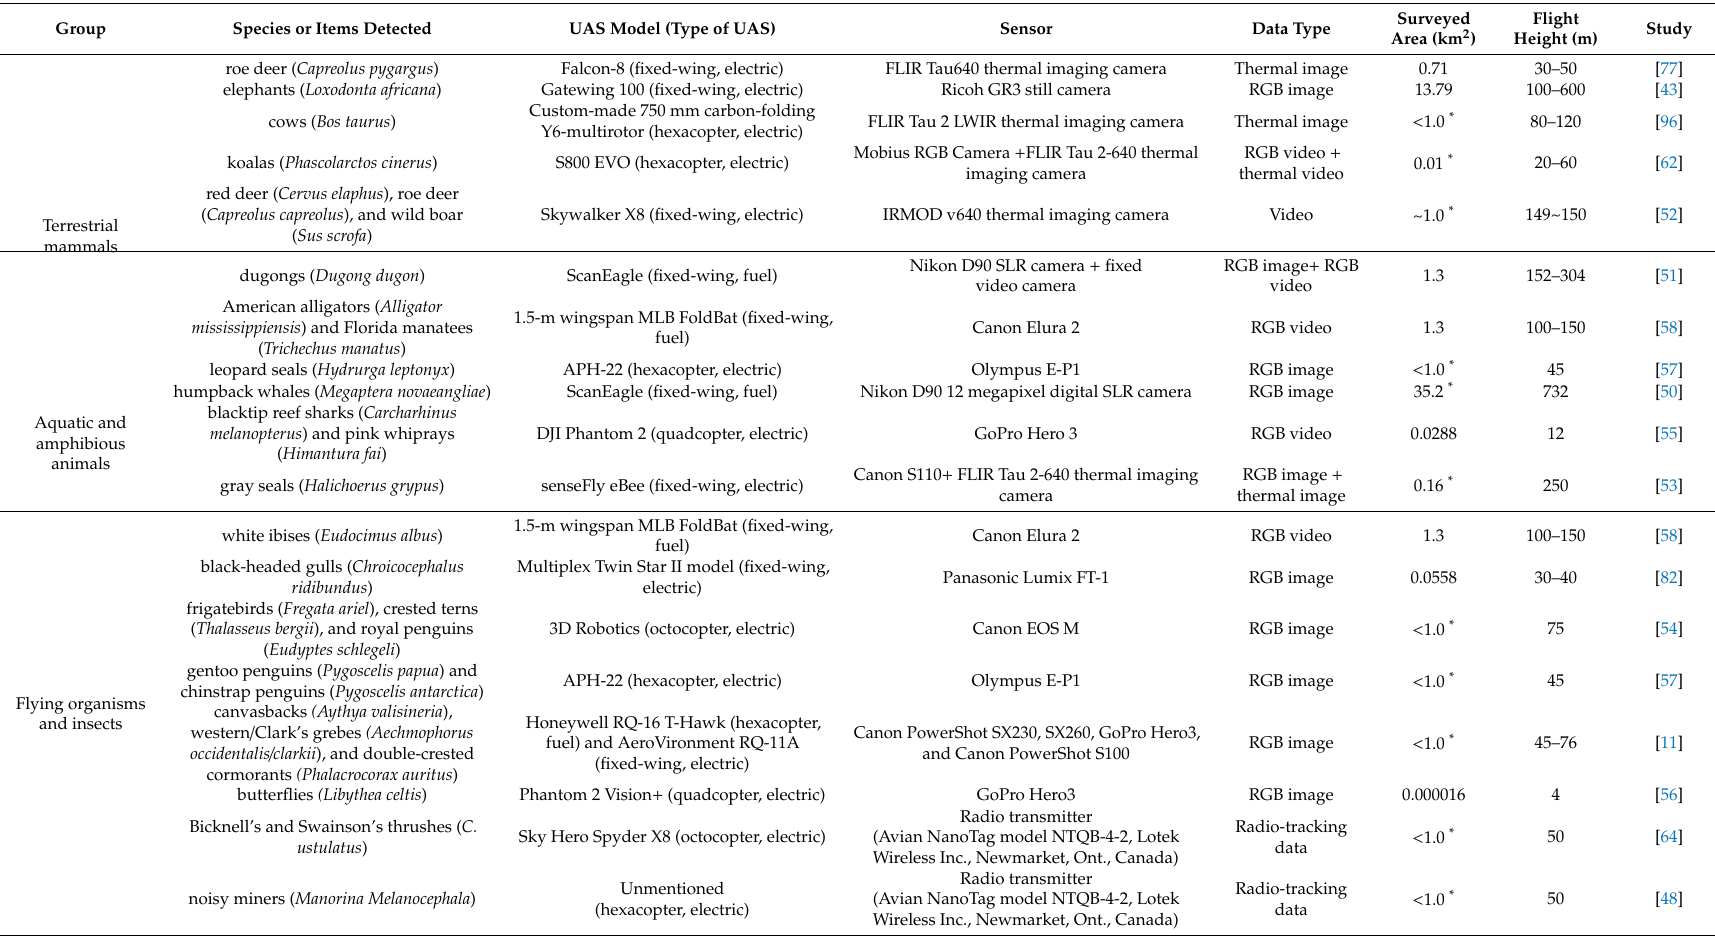
Table 5. Detected animal species and employed unmanned aerial systems (UASs) determined via a literature